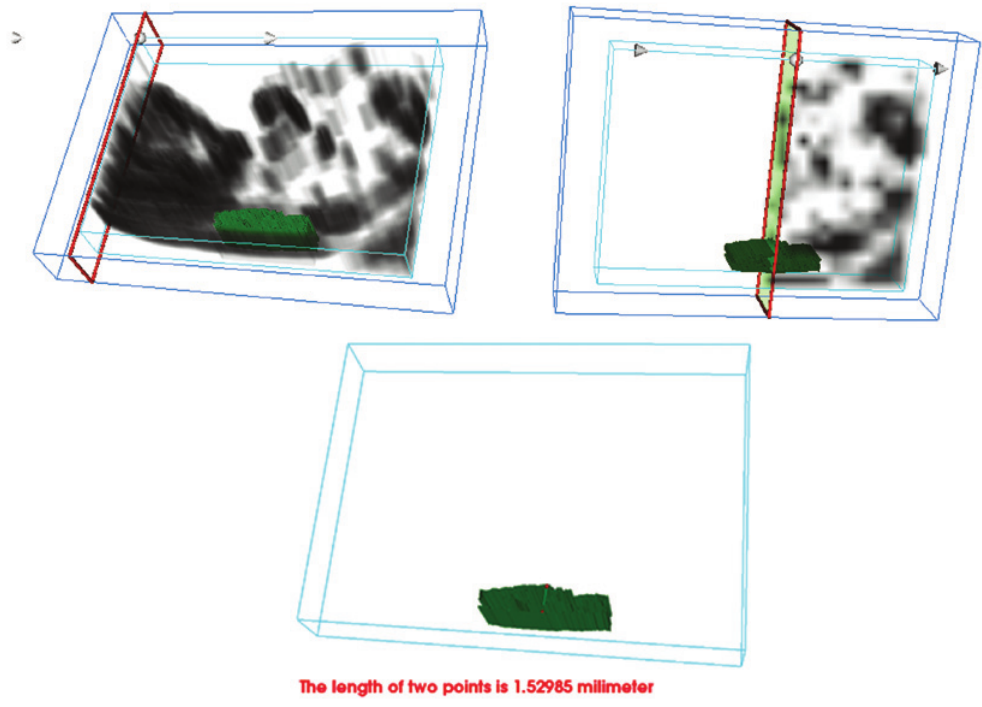
Fig. 3 - Three dimensional nuchal translucency simulation (a) 3D volumetric rendering (b) Slicing view to show for NT segmentation (c) Thickness measurement using 3D Euclidean approach.